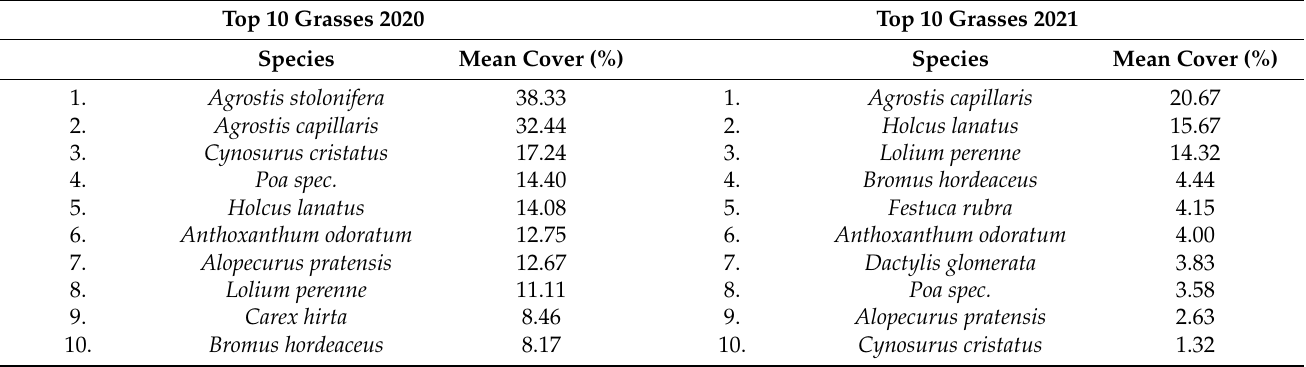
Table 7. Mean coverage (%) of the top 10 grasses and herbs according to the Londo method in 2020 and